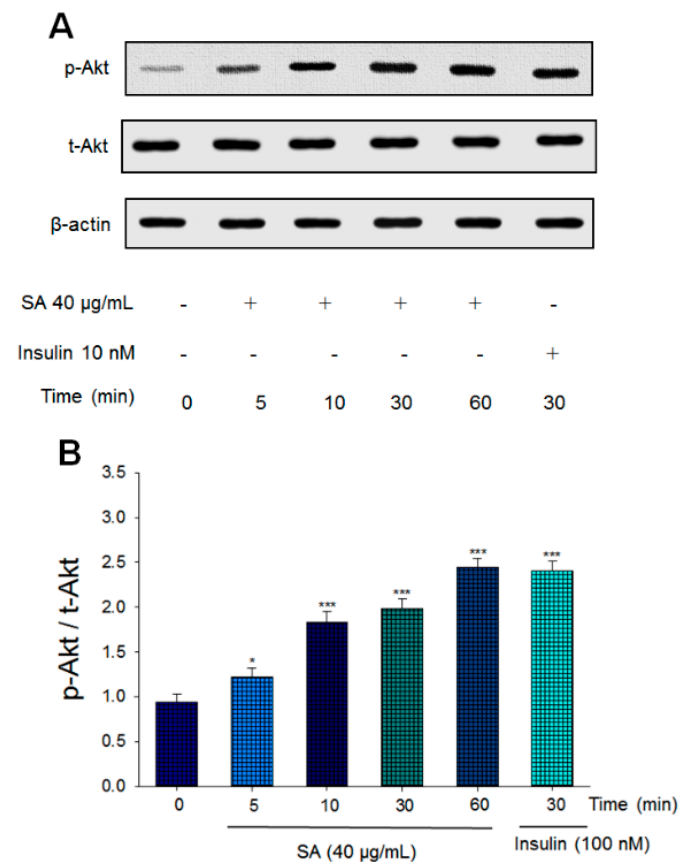
Figure 2. Sulphurenic acid (SA) activates Akt signaling pathways. The cell lysates were analyzed via blotting for phospho-Akt (p-Akt) and total-Akt (t-Akt). ( A ) Representative image; Akt phosphorylation was determined from C2C12 cells, and treated with 40 µ g / mL of SA for the indicated period of time (5–60 min); ( B ) The ratios of p-Akt to t-Akt forms were analyzed and presented as phosphorylation of Akt. * p < 0.05, *** p < 0.001 compared with the 0 min group. All values are means ± SE ( n =